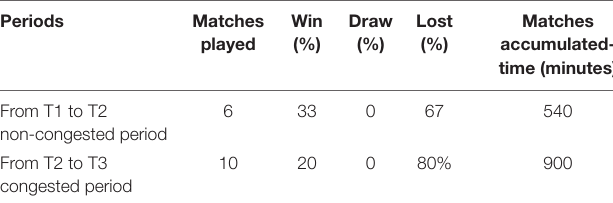
TABLE 5 | Performance of the soccer team during the congested and non-congested period. Periods Matches